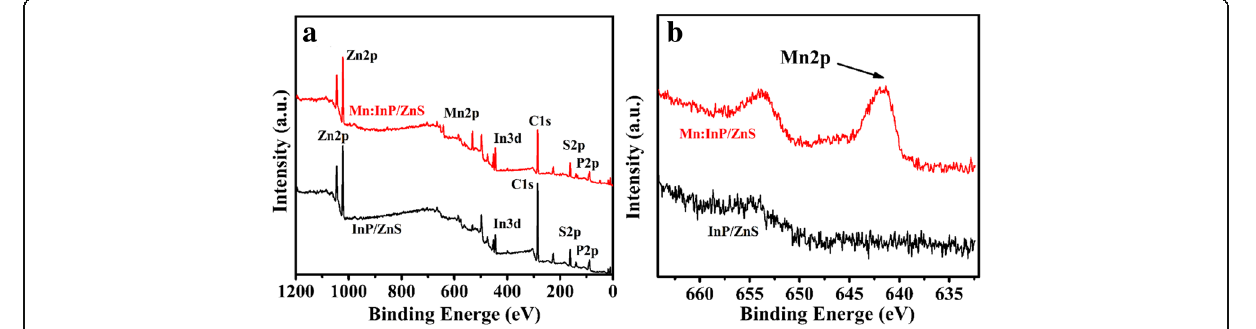
Fig. 3 a XPS patterns of InP/ZnS and Mn:InP/ZnS QDs. b HRXPS patterns of Mn